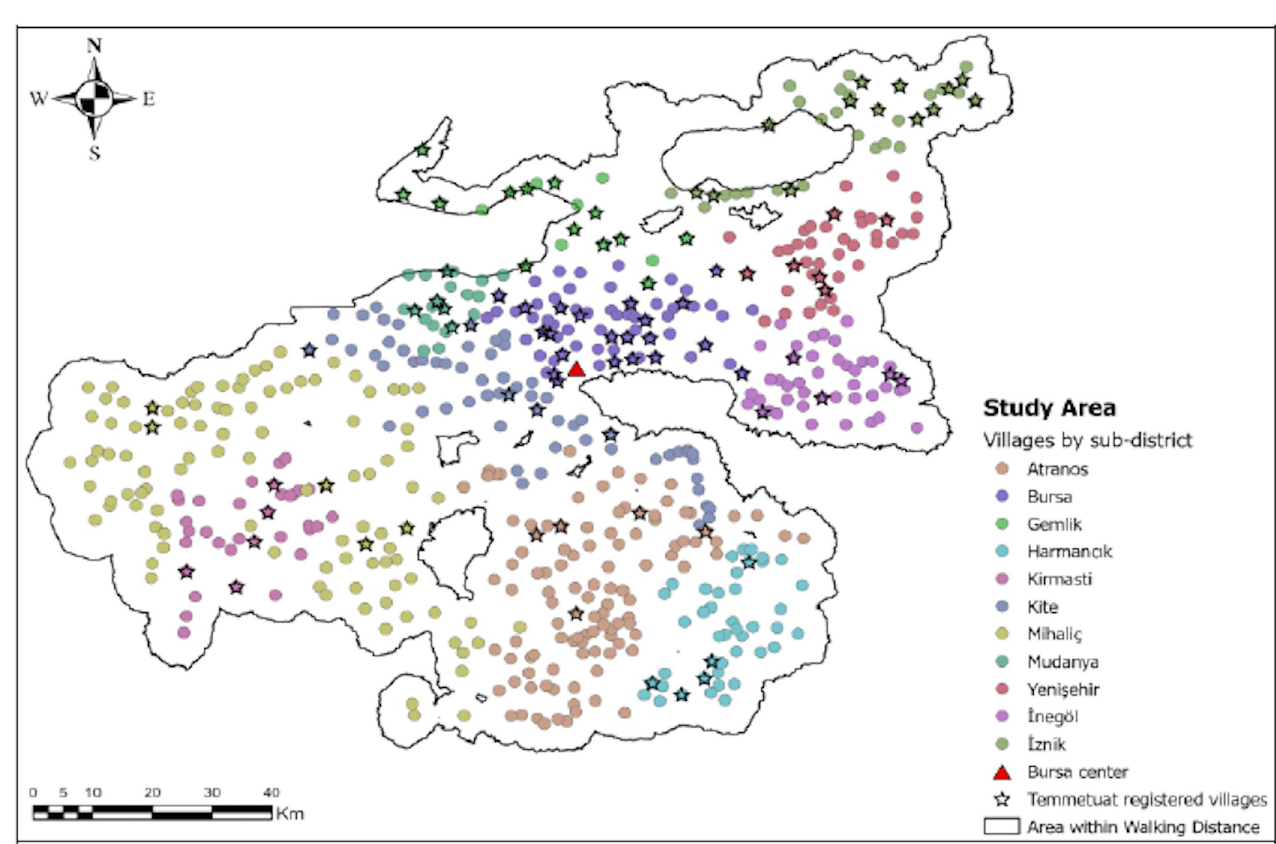
Fig 2. The study